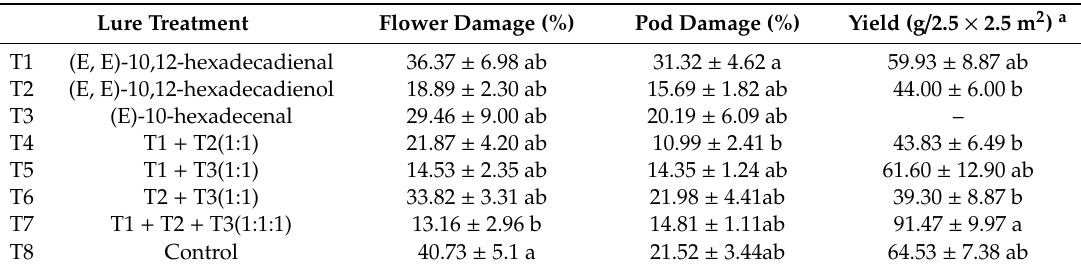
Table 3. Mean ( ± SE) flower and pod damage caused by M. vitrata and grain yield of mung bean crop. Means followed by di ff erent letters in a column are significantly di ff erent, as determined by Tukey’s post hoc test ( p <